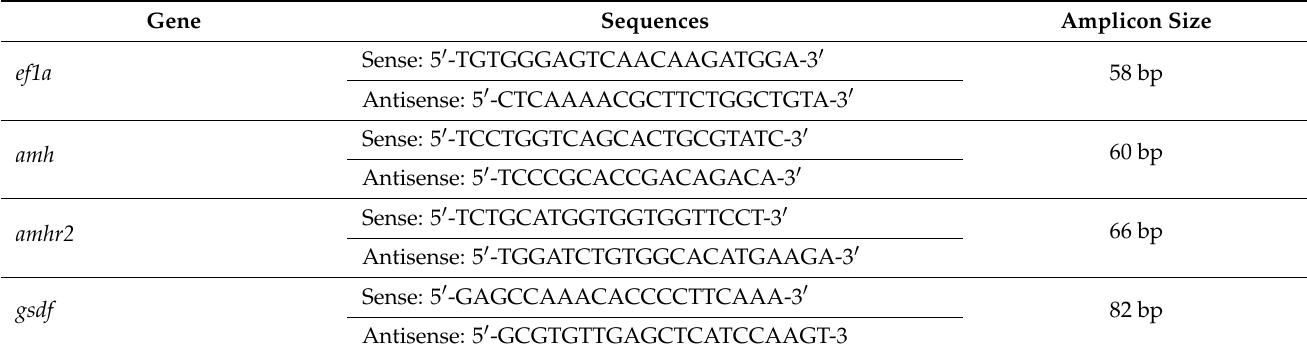
Table 1. Specific primers used for real-time quantitative polymerase chain reaction (PCR) analyses. Gene